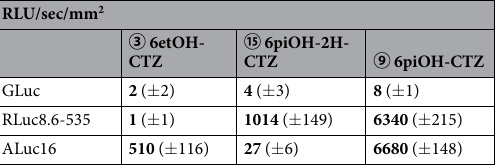
(Fig. 3). The optical intensities from COS-7 cells coexpressing ERS and TP2.4 were developed with D-Luciferin,